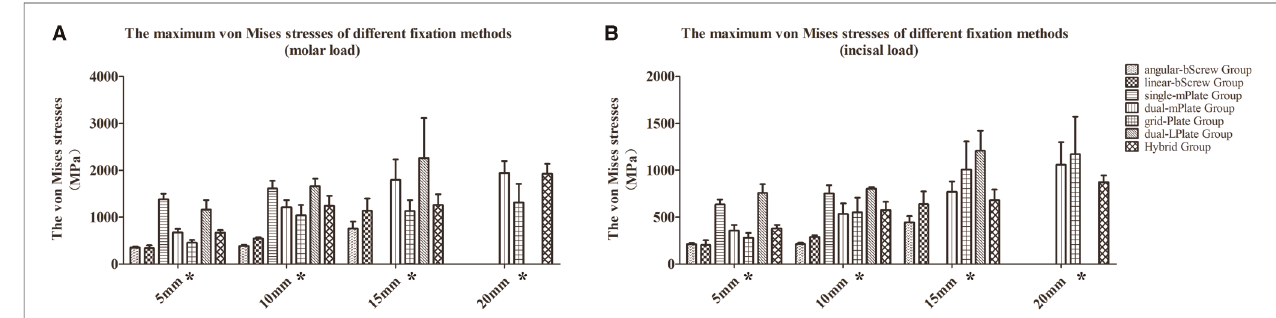
FIGURE 8 | Maximum von Mises stresses of seven fi xation methods under molar ( A ) and incisal ( B ) load conditions. * p